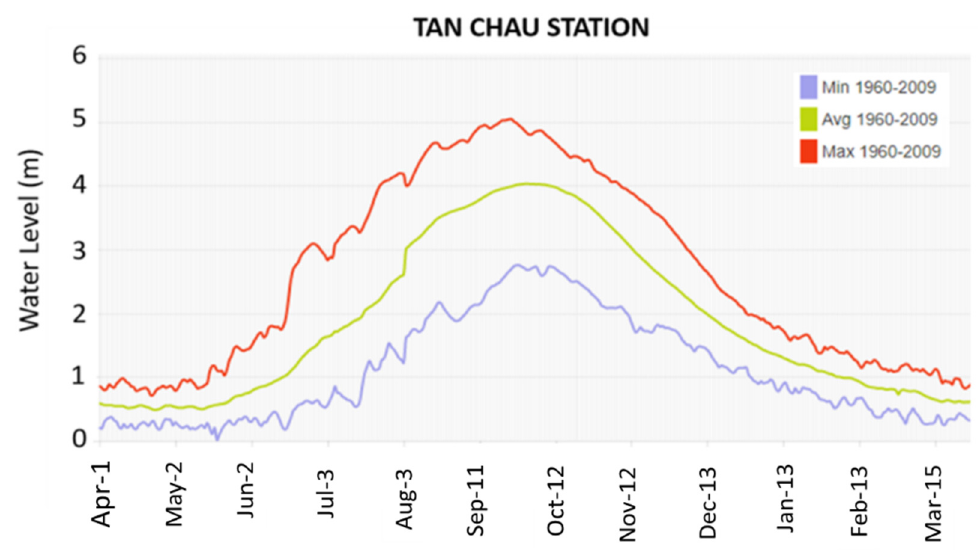
Figure 2. Water level at Tan Chau gauge station in An Giang province from 1960 to 2009 (http://portal.mrcmekong.org/charts/chart, accessed on 1 January 2020).